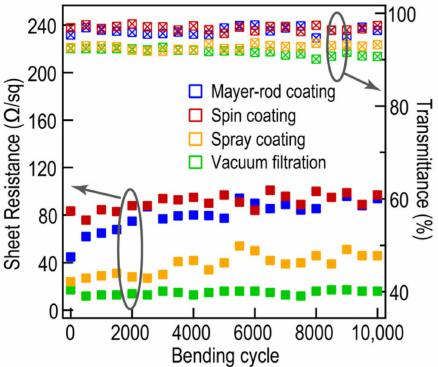
Figure 5. Sheet resistance and optical transmittance for the Ag NW/PMMA films by different methods after 10,000 bending cycles under 50% strain.